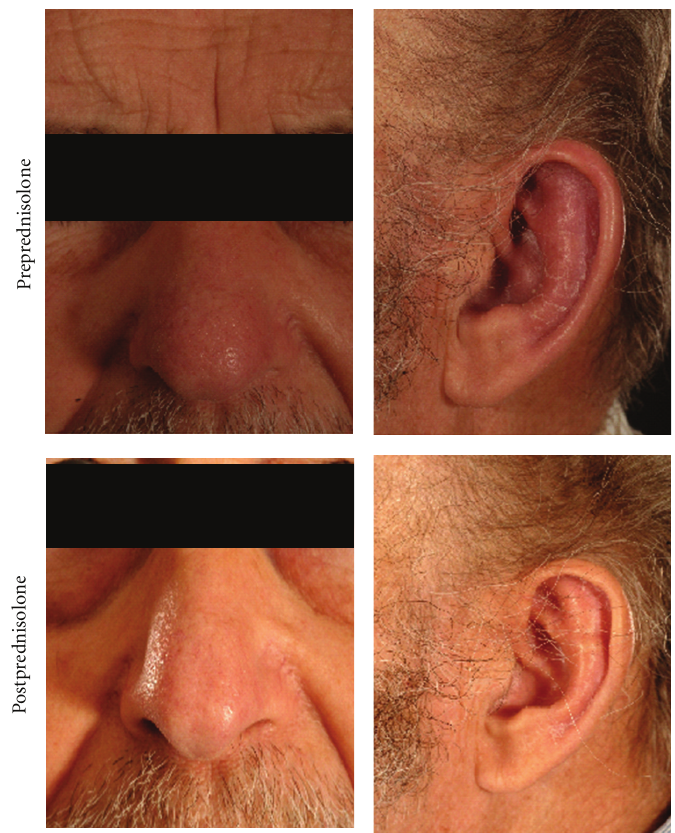
Figure 1: Erythema of nasal and auricular cartilage with ear lobe sparing pre and post treatment with